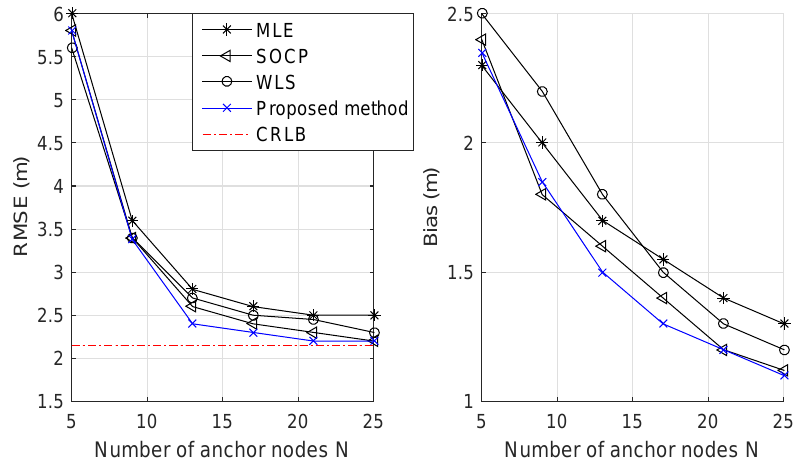
Figure 5. RMSE versus number of anchor nodes N .